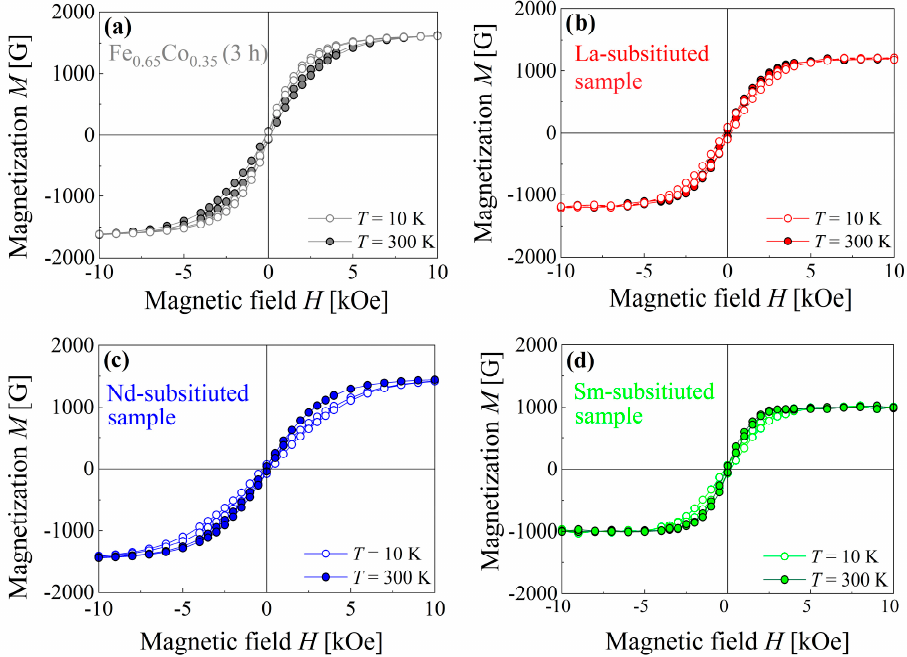
Figure 7. Magnetization M as a function of the magnetic field H for ( a ) Fe 0.65 Co 0.35 (3 h) alloy and (Fe 0.65 Co 0.35 ) 0.95 ( RE 2 O 3 ) 0.05 samples with RE = ( b ) La, ( c ) Nd, and ( d ) Sm, recorded at 10 K and 300 K. Table 3 summarizes the magnetic properties of saturation magnetization ( M s ), coercive field ( H c ), remnant magnetization ( M r ) and magnetic energy product ( E M ) derived from these hysteresis loops for all investigated compositions. Table 3. The magnetic properties of RE -substituted Fe 0.65 Co 0.35 (3 h)